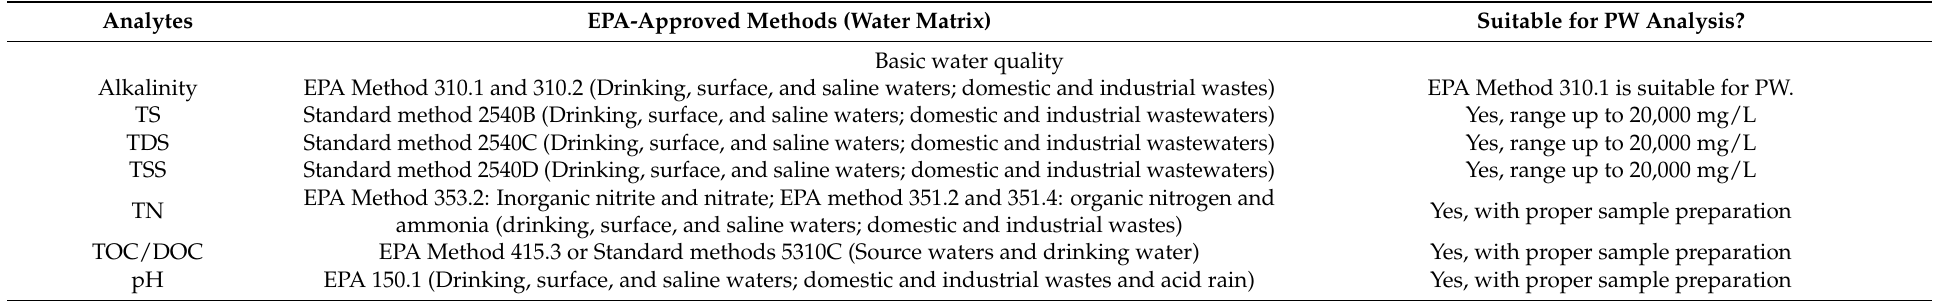
Table 4. Summary of standard analytical methods and methods used in commercial labs, and advanced characterization research methods for targeted and unknown